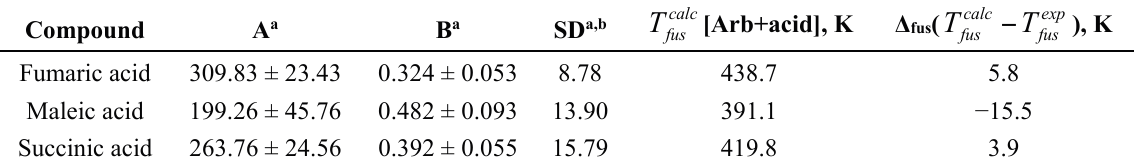
Table 4. Coefficients of the correlation equation (1) for multicomponent crystals with selected dicarboxylic acids, calculated values of melting temperatures ( calc salts/co-crystal, and difference ( Δ fus ) between calculated and experimental melting temperatures for the Arb